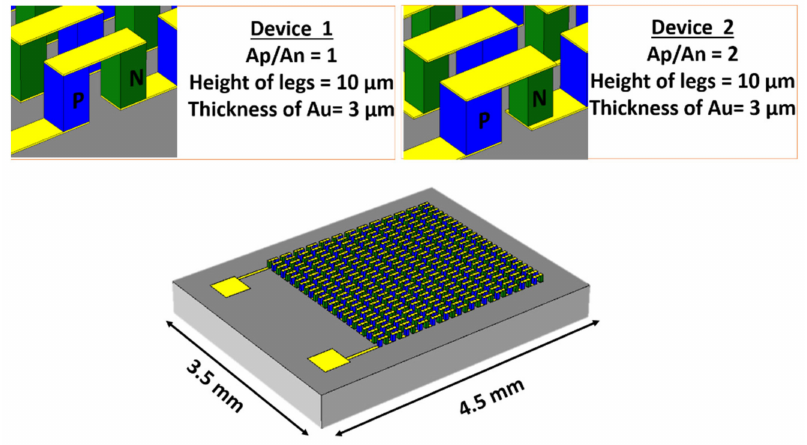
Figure 8. Schematic diagram of optimized devices.